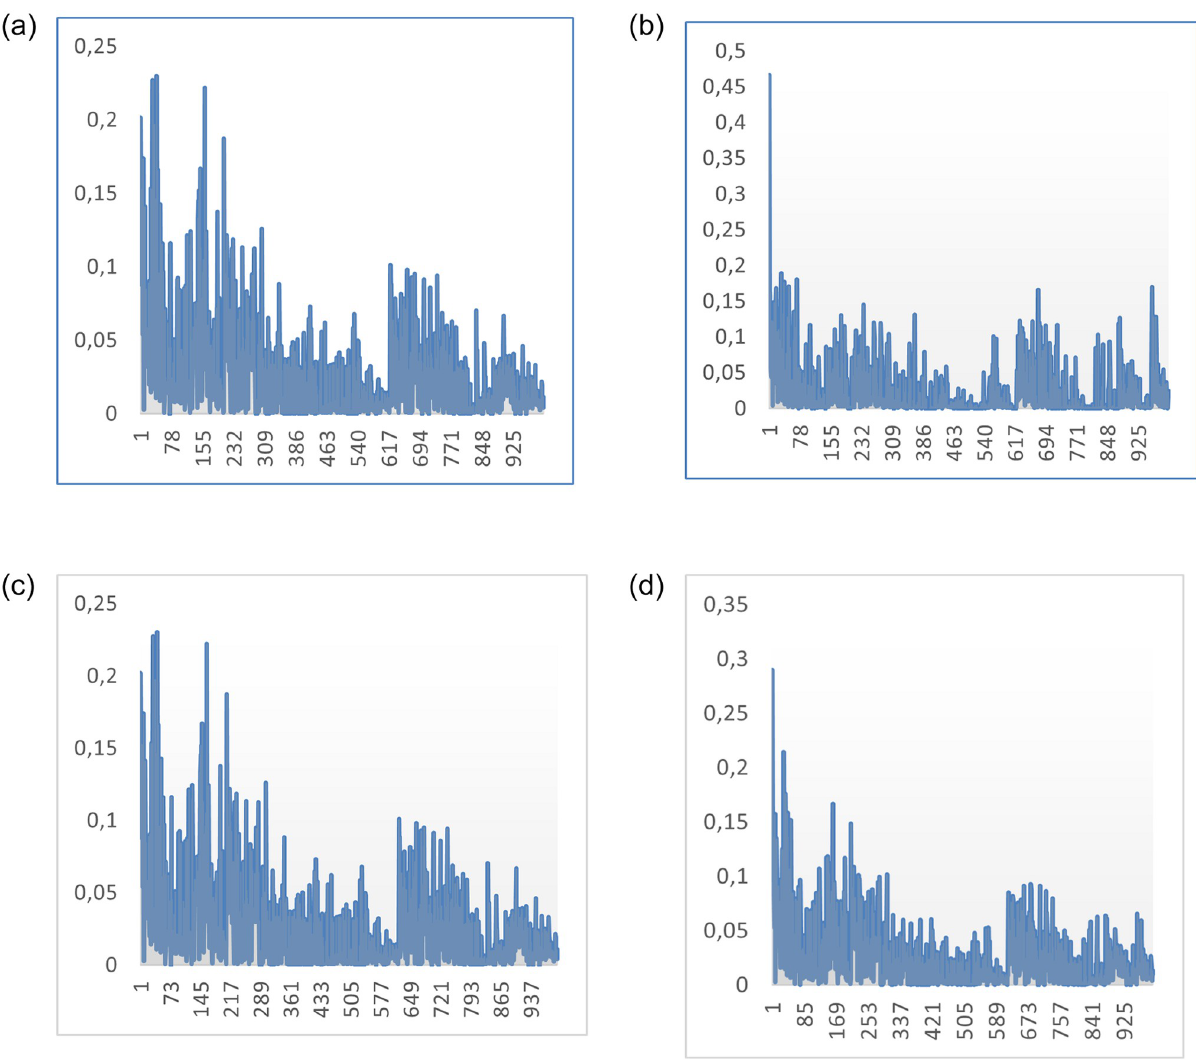
Fig 16. An overview of obtained trusted features for first 1000 users in the Brightkite dataset. (a) User centrality, (b) location proximity, (c) Service quality (actual ratings), (d) social